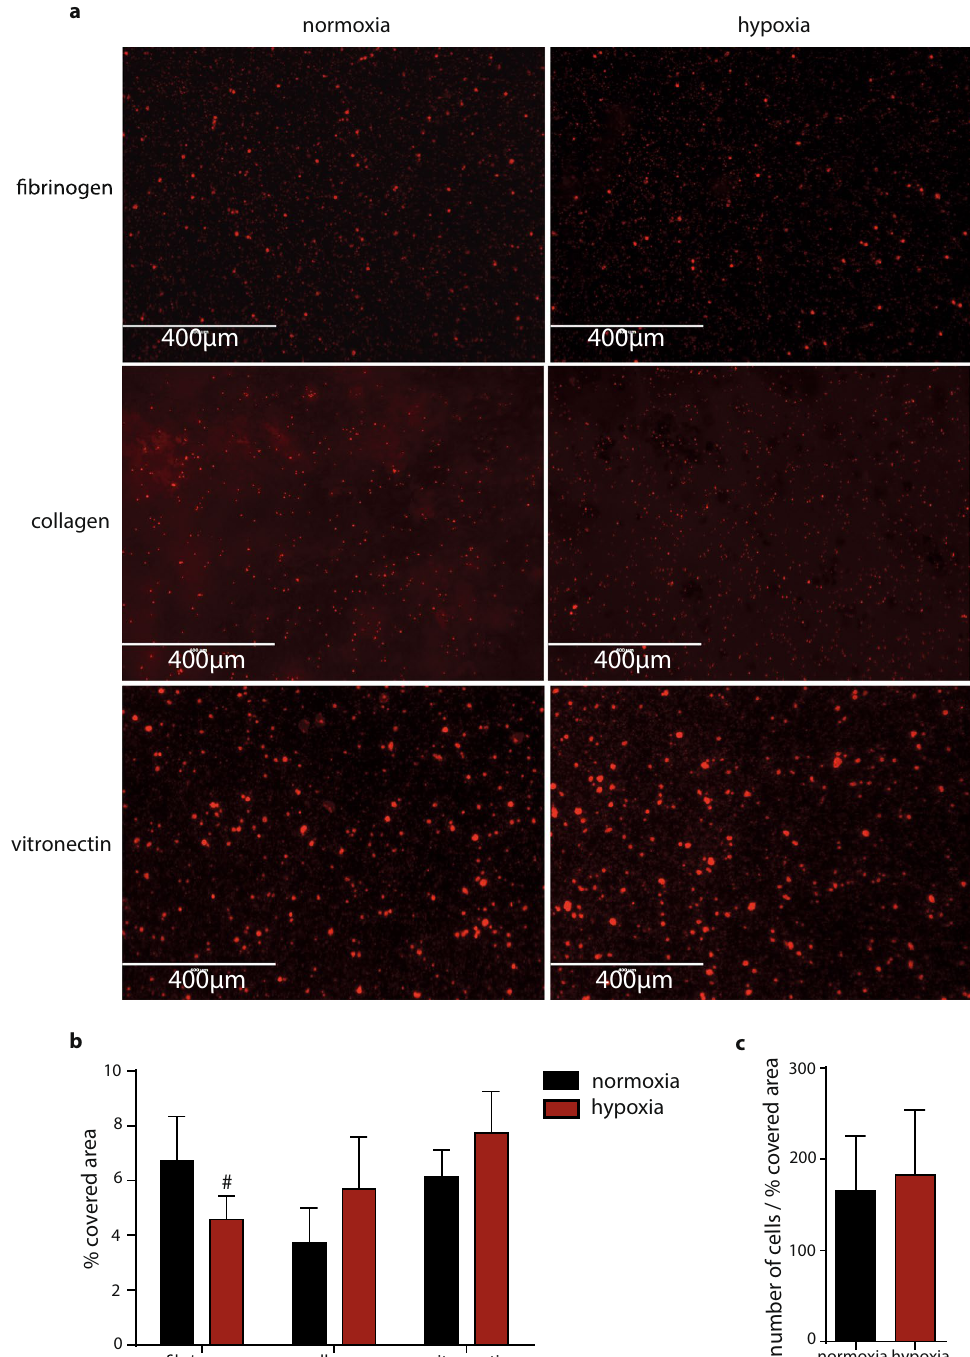
Figure 4. Platelet adhesion on fibrinogen, collagen, and vitronectin coated slides in hypoxia (1% oxygen) and normoxia. ( a ) Representative images of platelet adhesion to fibrinogen (10 mg/ml) coated slides after incubation for 30 min in normoxia (left) and hypoxia (right). Representative images of platelet adhesion to collagen coated slides after incubation for 30 min in normoxia (left) and hypoxia (right). Representative images of platelet adhesion to vitronectin (20 µ g/ml) coated slides after incubation for 30 min in normoxia (left) and hypoxia (right). ( b ) % of covered area by platelets on fibrinogen (n = 9, p = 0.0337), collagen (n = 4), and vitronectin (n = 4) coated slides after incubation for 30 min in normoxia (black) and hypoxia (red). ( c ) ratio of the number of platelets to % of covered area adherent on fibrinogen slides after 30 min incubation in normoxia or hypoxia. All data were expressed as the means ± SEM. Statistical comparisons were performed using the paired Student’s t -test, # p < 0.05, sample from fibrinogen binding are distributed normally according to D’Agostino & Pearson omnibus, Shapiro-Wilk normality test and Kolmogorov-Smirnov normality tests. The samples from the adhesion to collagen coated and vitronectin coated slides were analyzed with the Mann-Whitney